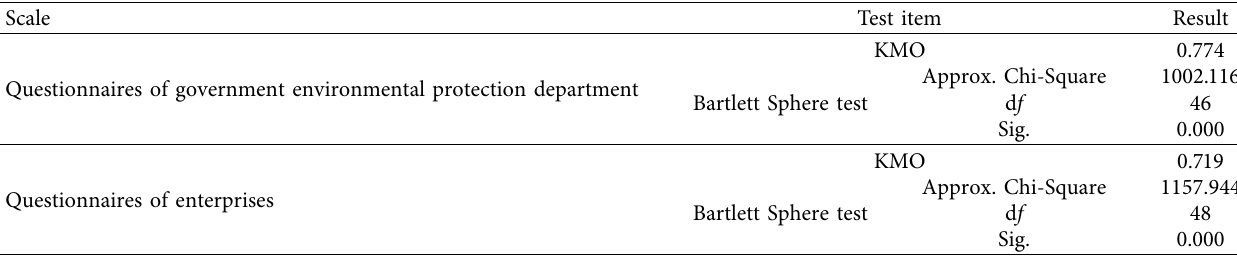
Table 5: Results of KMO and Bartlett Sphere test.